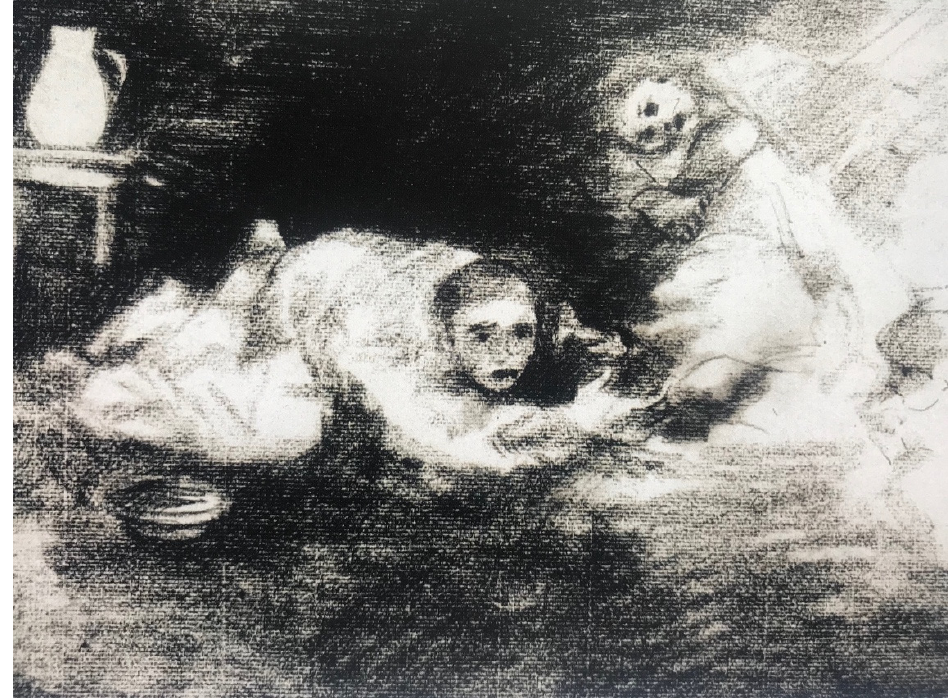
Figure 3. Vasily Chekrygin, From the Povolzhye Famine series , 1922, pencil and charcoal on paper, collection of K.I. Grigorishin, Moscow.